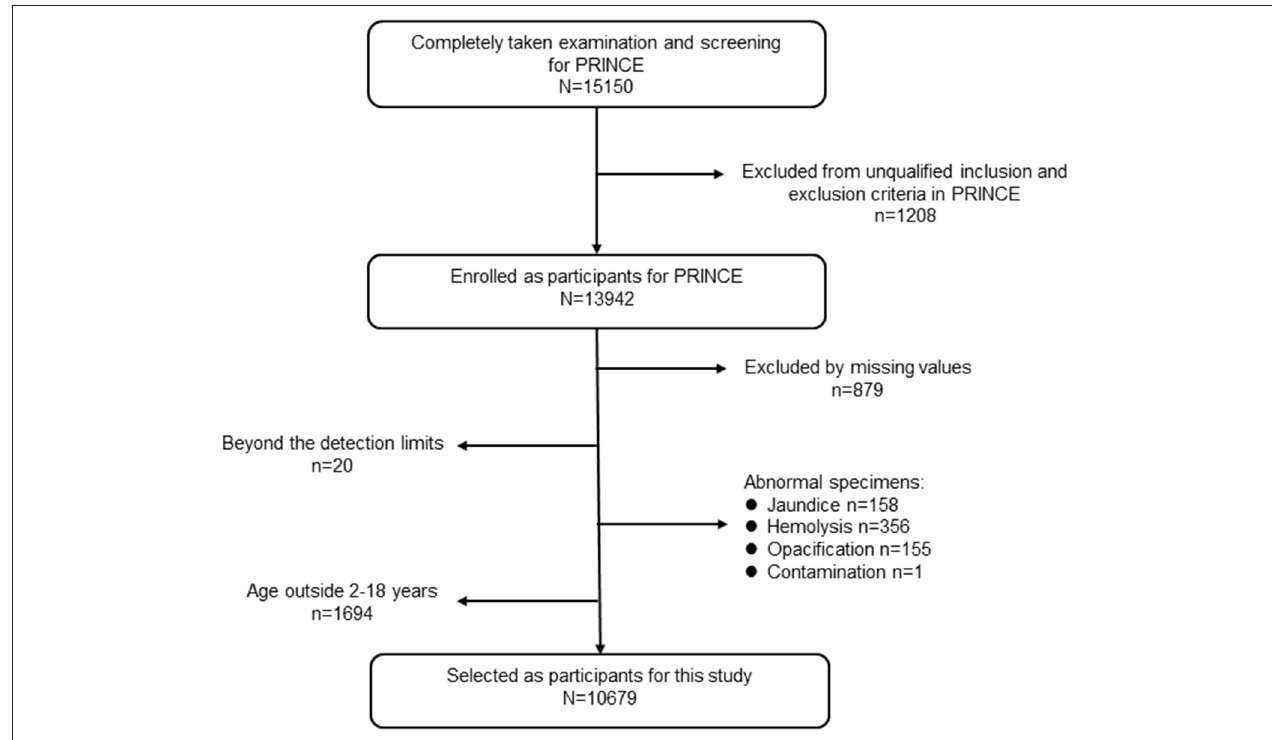
FIGURE 1 | The flowchart of the study population from the PRINCE